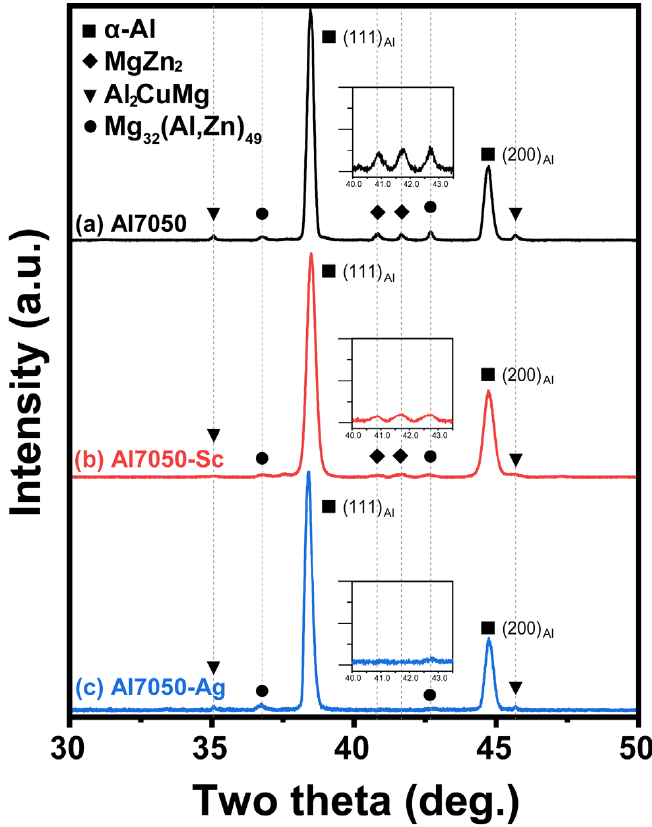
Figure 2. XRD profiles of ( a ) Al7050, ( b ) Al7050-Sc, and ( c ) Al7050-Ag.